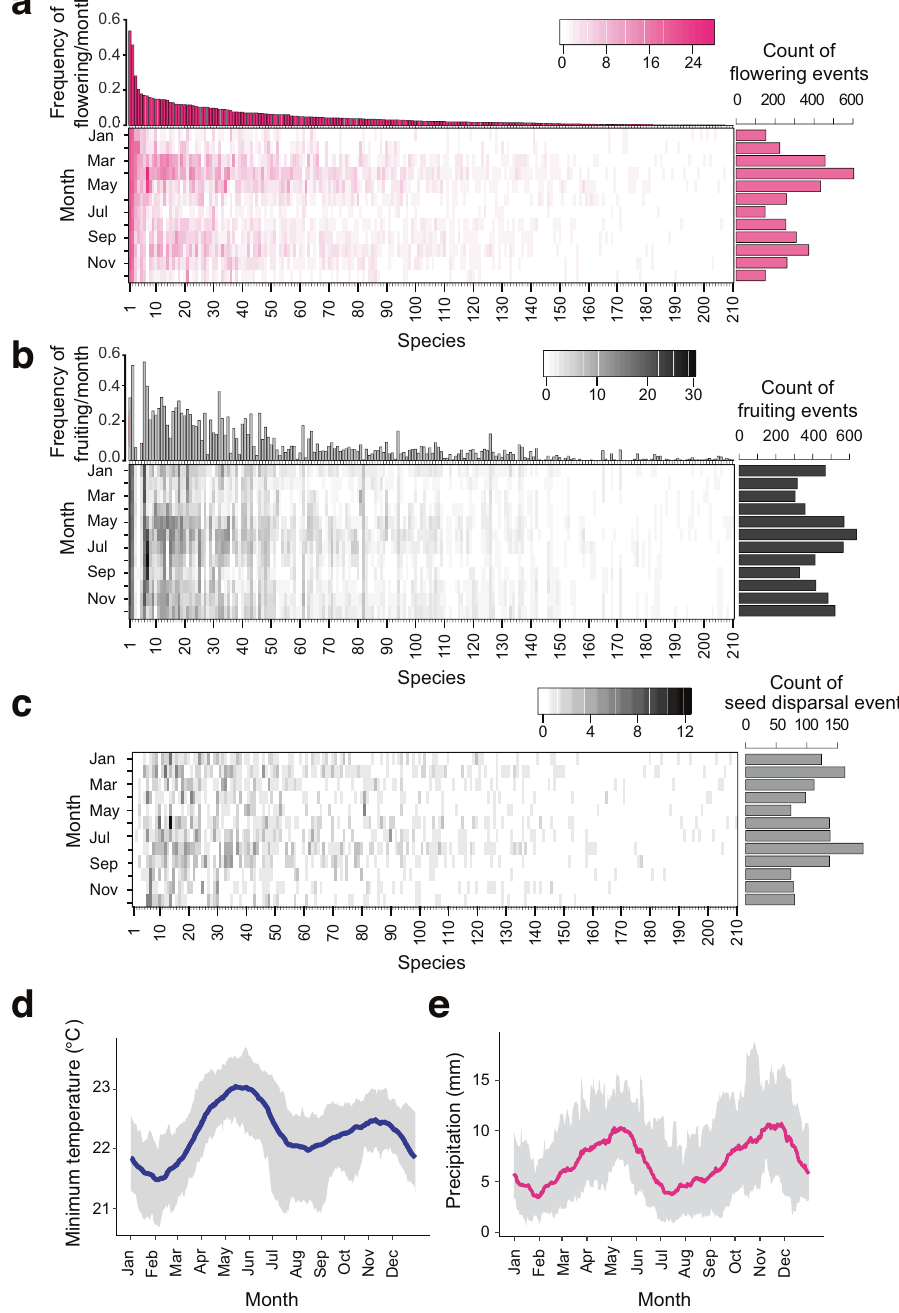
Fig. 2 Frequency and seasonality of reproductive events. The frequency and seasonal trends of fl owering ( a ), fruiting ( b ), and seed dispersal ( c ) events in 210 tropical tree species. The number given to each species corresponds to the species name shown in Supplementary Data 2. d Average (line) ± standard error (envelope) of temperature calculated from the 30-day running means during 1976 – 2010. e Average (line) ± standard error (envelope) of precipitation calculated from the 30-day running means during 1976 –